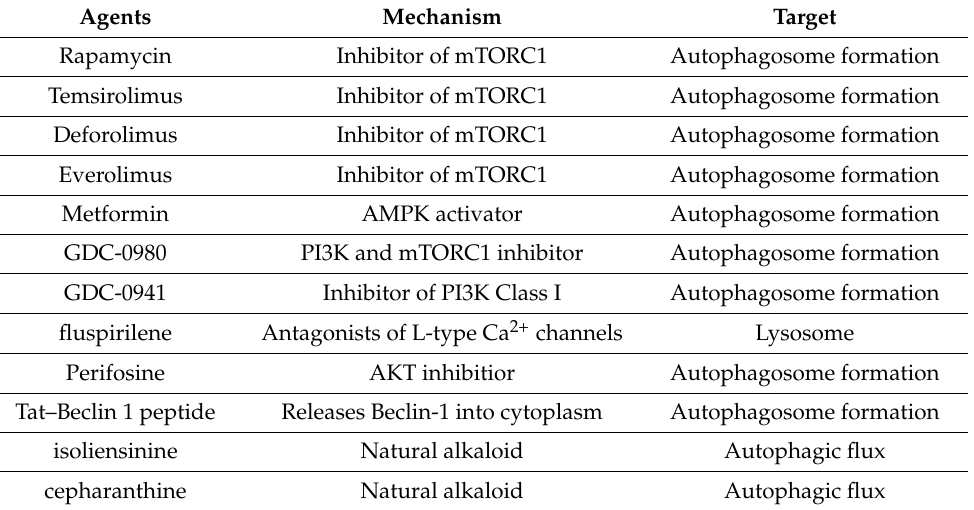
Table 3. Small agents and drugs that induce autophagy. In the table, molecules and drugs that have been identified as autophagy inducers are shown. Moreover, the main mechanism of action and the target point in the autophagy procedure where they act are